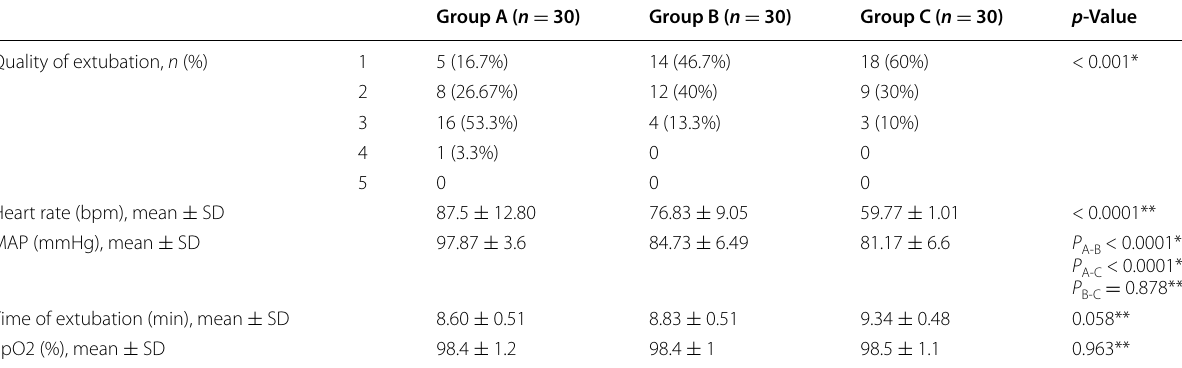
Table 2 Quality of extubation and hemodynamic parameter at extubation of the three groups